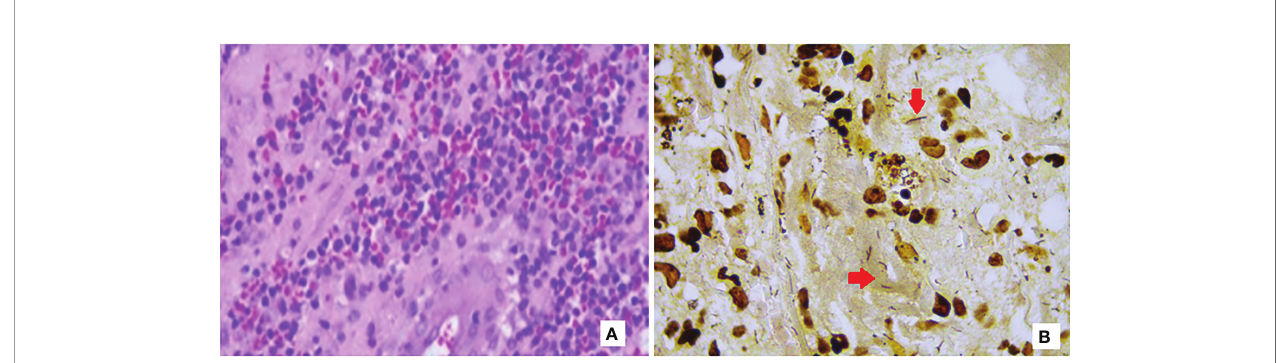
FIGURE 2 | Hematoxylin-eosin (A) and Warthin-Starry (B) stainings showing a mixed in fl ammatory in fi ltrate from the skin biopsy from Case 1 and spiral-shaped bacilli among the in fi ltrates.